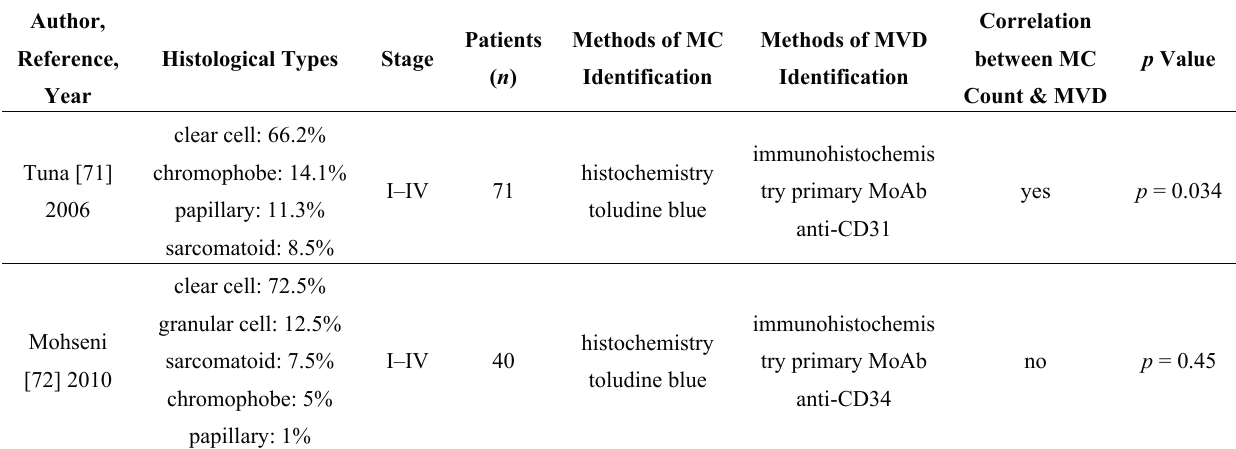
Table 2. Studies correlating mast cell (MC) count with microvascular density (MVD) in renal cancer patients.